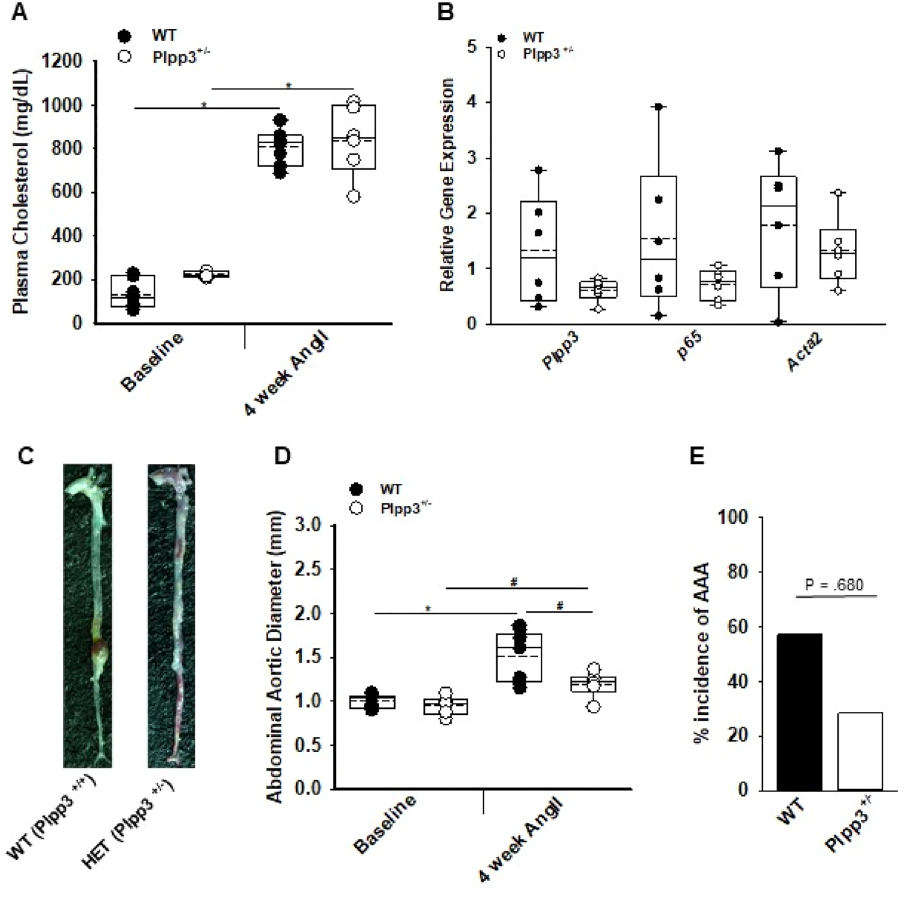
Figure 2. Reduced Plpp3 expression protects against abdominal aortic aneurysm development. ( A ) Plasma cholesterol at baseline and post-4 week AngII were measured in WT (n = 7) and Plpp3 + /− (n = 6) mice, * P < 0.001, Two-way ANOVA, Bonferroni t-test, all pairwise multiple comparison. ( B ) Abdominal aorta gene expression from WT (n = 6) and Plpp3 + /− (n = 6) following AngII treatment. ( C ) Representative images of aortas from WT and Plpp3 + /− . ( D ) Abdominal aortic diameter measurements of WT (n = 9) and Plpp3 + /− (n = 6) were measured using ultrasound at baseline and 4 week AngII,* P < 0.001, # P < 0.05, Two-way ANOVA, Holm-Sidak, all pairwise multiple comparison. ( E ) Percent incidence of AAA in WT (n = 9) and Plpp3 + /− (n = 6) mice treated with AngII for 4 weeks P = 0.068 by Fischer’s exact